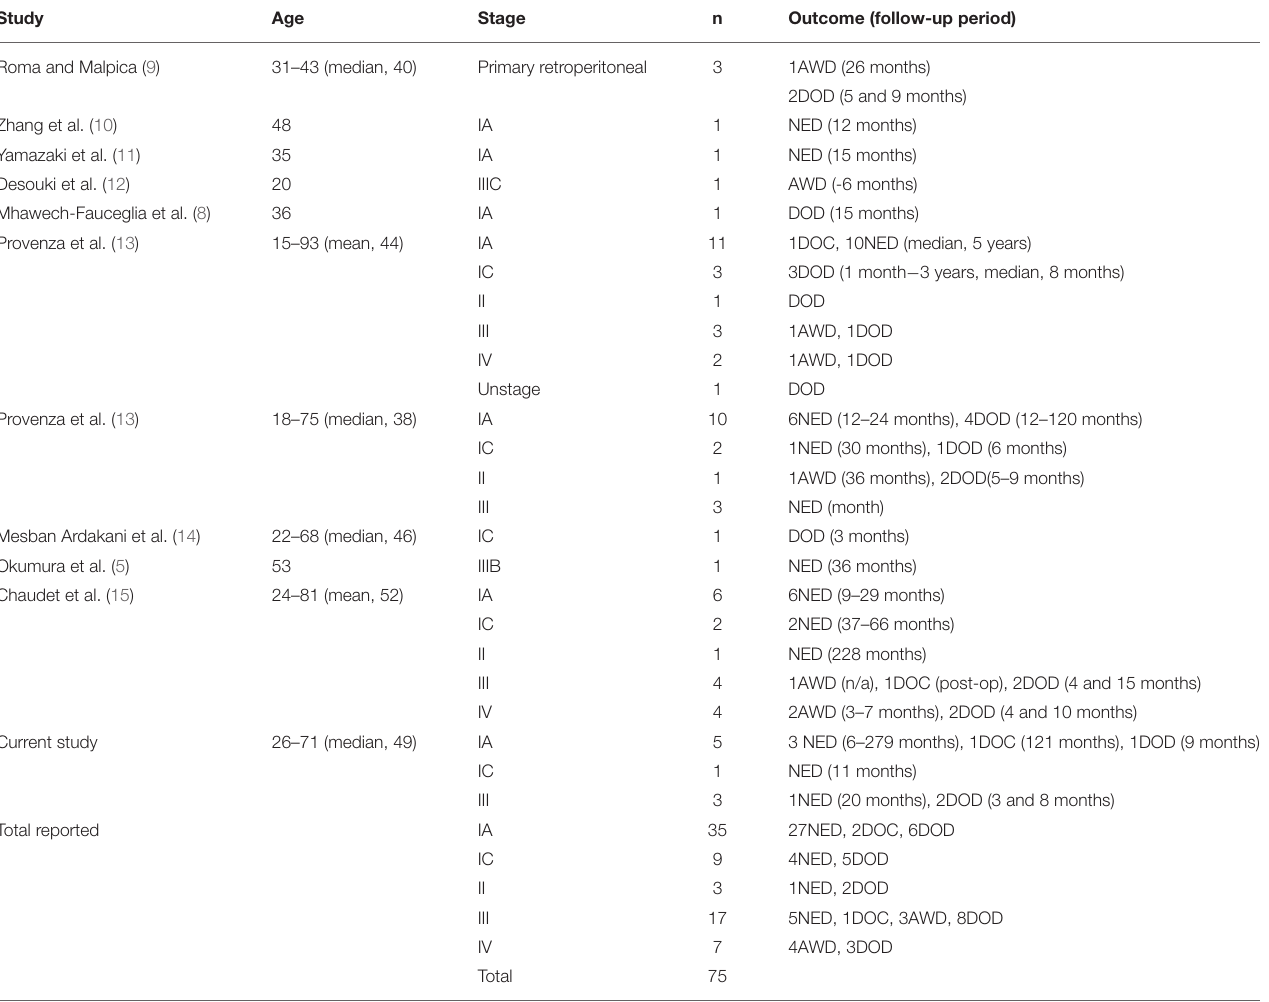
TABLE 1 | Summary of published mural nodules of anaplastic